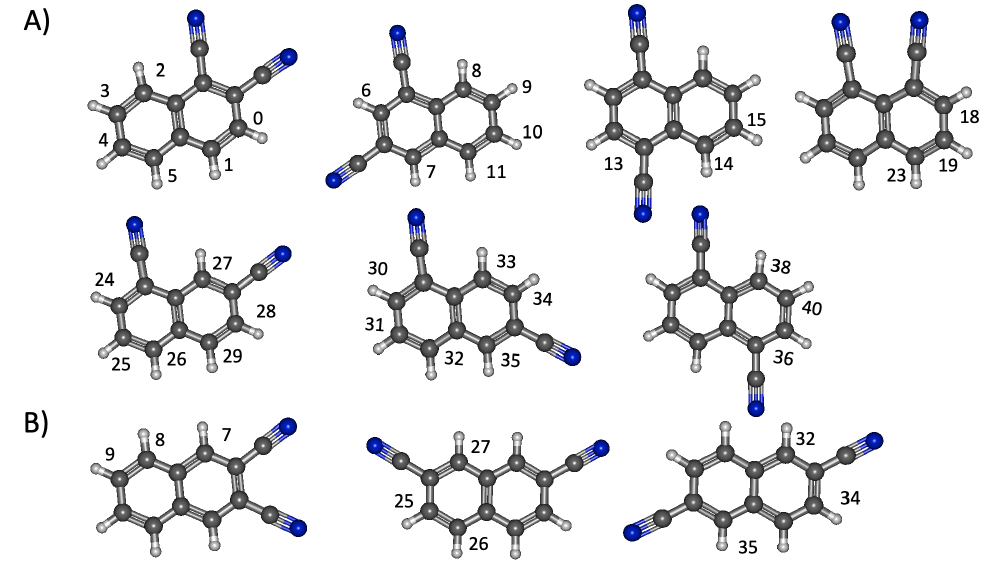
Figure 3. The optimized structure of diethynlnaphthalene with numbered positions of deprotonation ( A ) 1-dicyanonaphthalene, ( B )